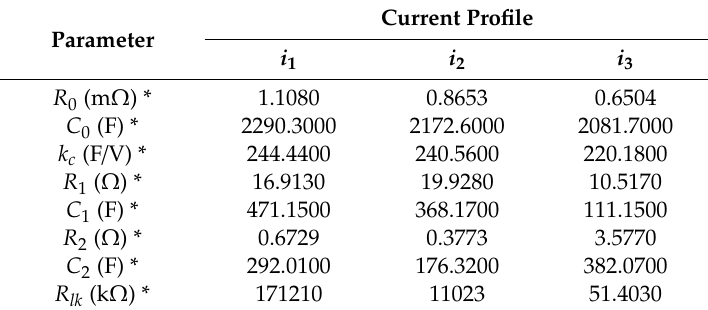
Table A2. Zubieta Model